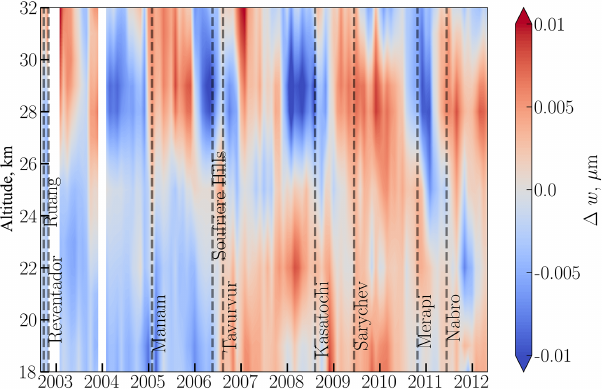
Figure 10. Monthly zonal mean values of w as defined by Eq. (2) re- trieved from SCIAMACHY limb data in the tropics (20 ◦ N–20 ◦ S).